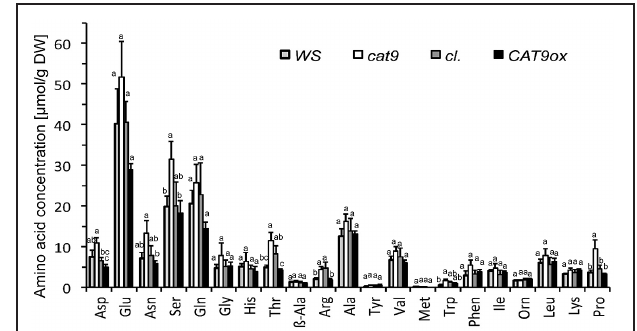
FIGURE 8 | Amino acid profile of leaves after 2 weeks of nitrogen starvation. Individual amino acids in μ mol per dry weight ( n = 4). Three letter abbreviation of amino acids, the Ile data points overlap with OH-Lys. Note the significant differences in some amino acids ( p < 0.05, ANOVA). Bar colors: WS wild type (light gray), cat9-1 (white), cl (dark gray), and CAT9ox1